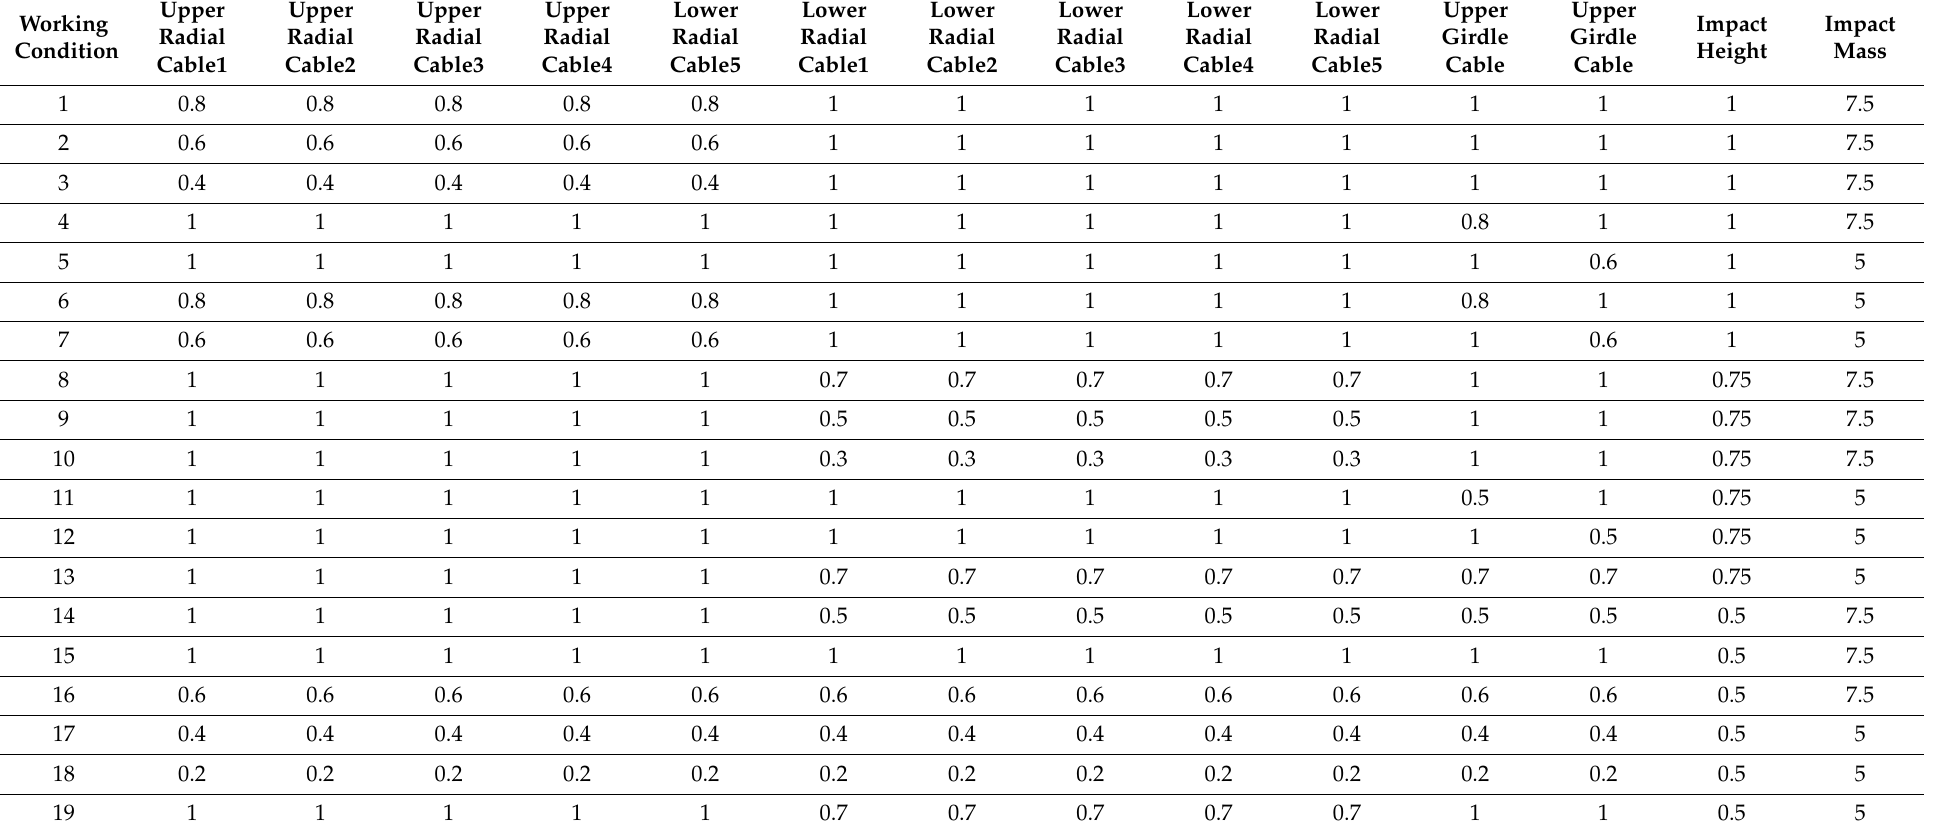
Table 2. The percentage of residual prestress of cable member